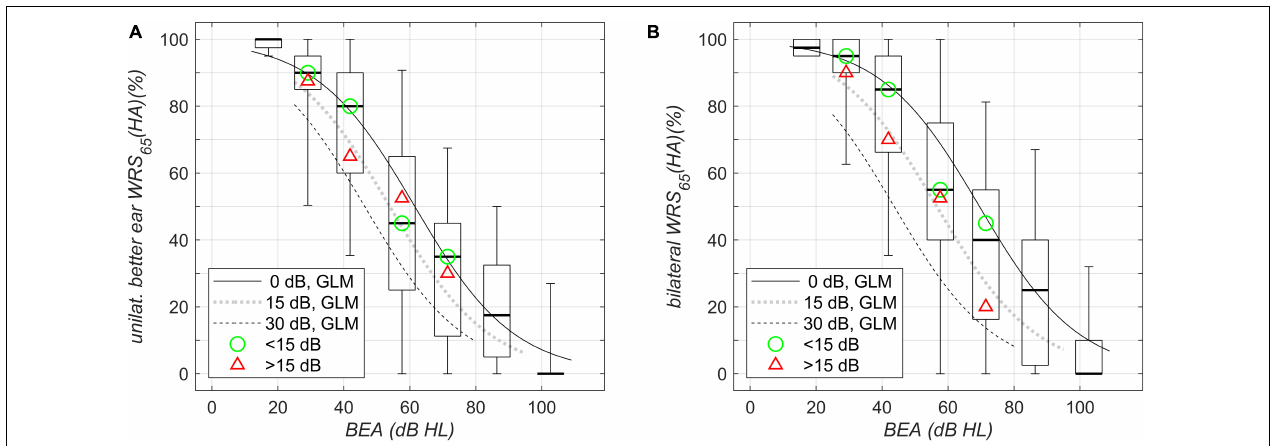
FIGURE 2 | Aided speech-recognition scores in quiet grouped by WHO classification of hearing loss and plotted against better-ear PTA (BEA). (A) Unilateral WRS (HA) 65 . (B) Bilateral WRS (HA) 65 . Boxplots and solid/dotted/dashed lines as in Figure 1A . The green circle and the red triangle in (A , B) denote the median of the data with corresponding WHO grade for asymmetries below and above 15 dB, respectively.